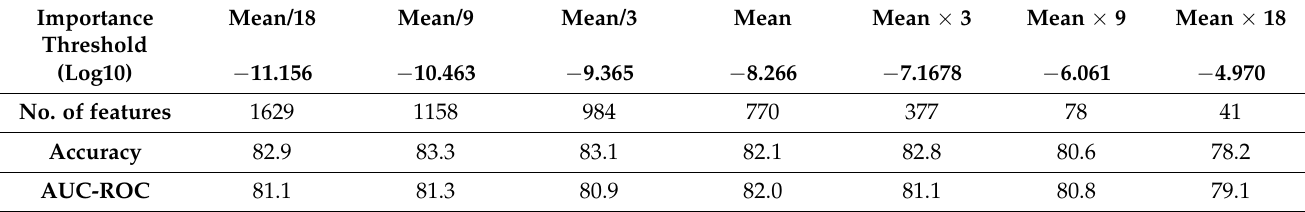
Table 2. Accuracy and AUC-ROC for features vs. different importance thresholds.